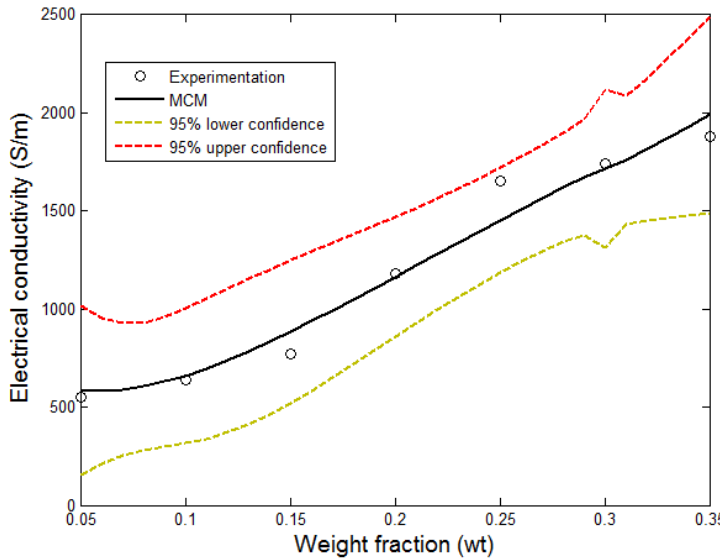
Figure 11. Comparison of experimental measurements with MCM.